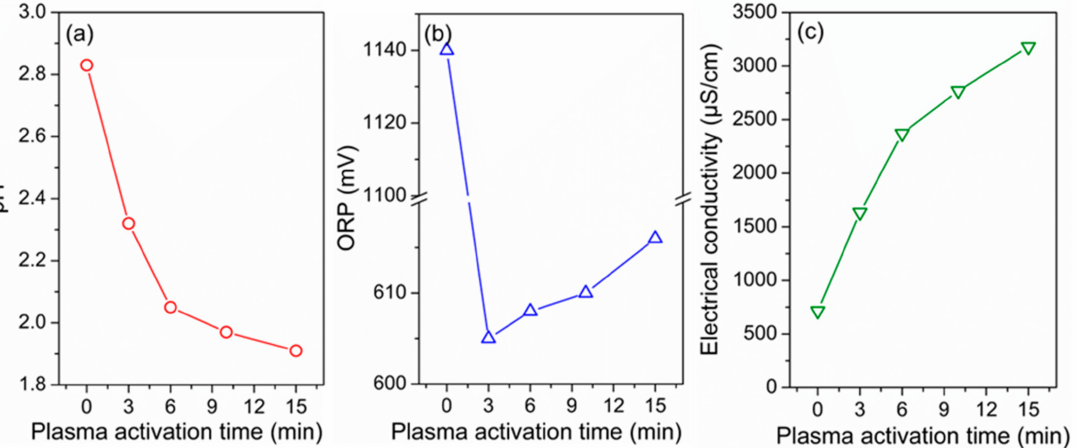
Figure 8. The values of pH ( a ), ORP ( b ) and EC ( c ) in PA-AEW accompanied by plasma activation